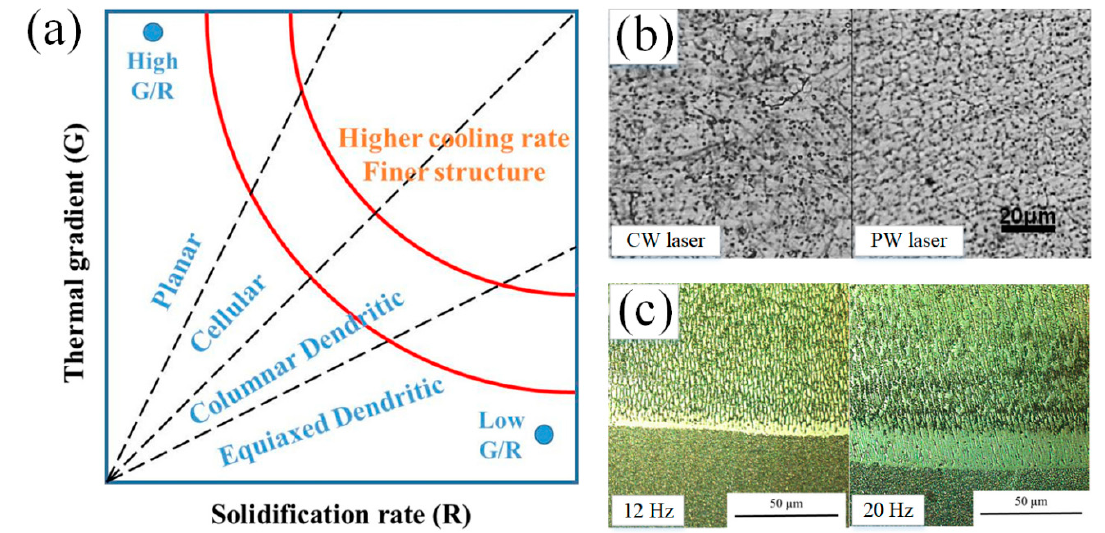
Figure 5. ( a ) Solidification map established by solidification parameters (Reprinted from ref. [27], copyright (2021), with permission from Elsevier); ( b ) Optical micrographs of CW and PW laser cladding Fe-based depositions (Reprinted from ref. [25], copyright (2014), with permission from Elsevier); ( c ) OM images of the intermixing zone of Inconel 713 deposition with a laser frequency of 12 Hz and 20 Hz (Reprinted from ref. [37], copyright (2021), with permission from